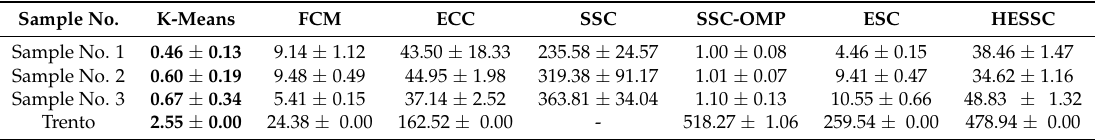
Table 5. Processing time (in seconds) for the clustering algorithms applied on three drill-core samples. Processing time on each sample is reported as mean and standard deviations over 10 trials. Sample